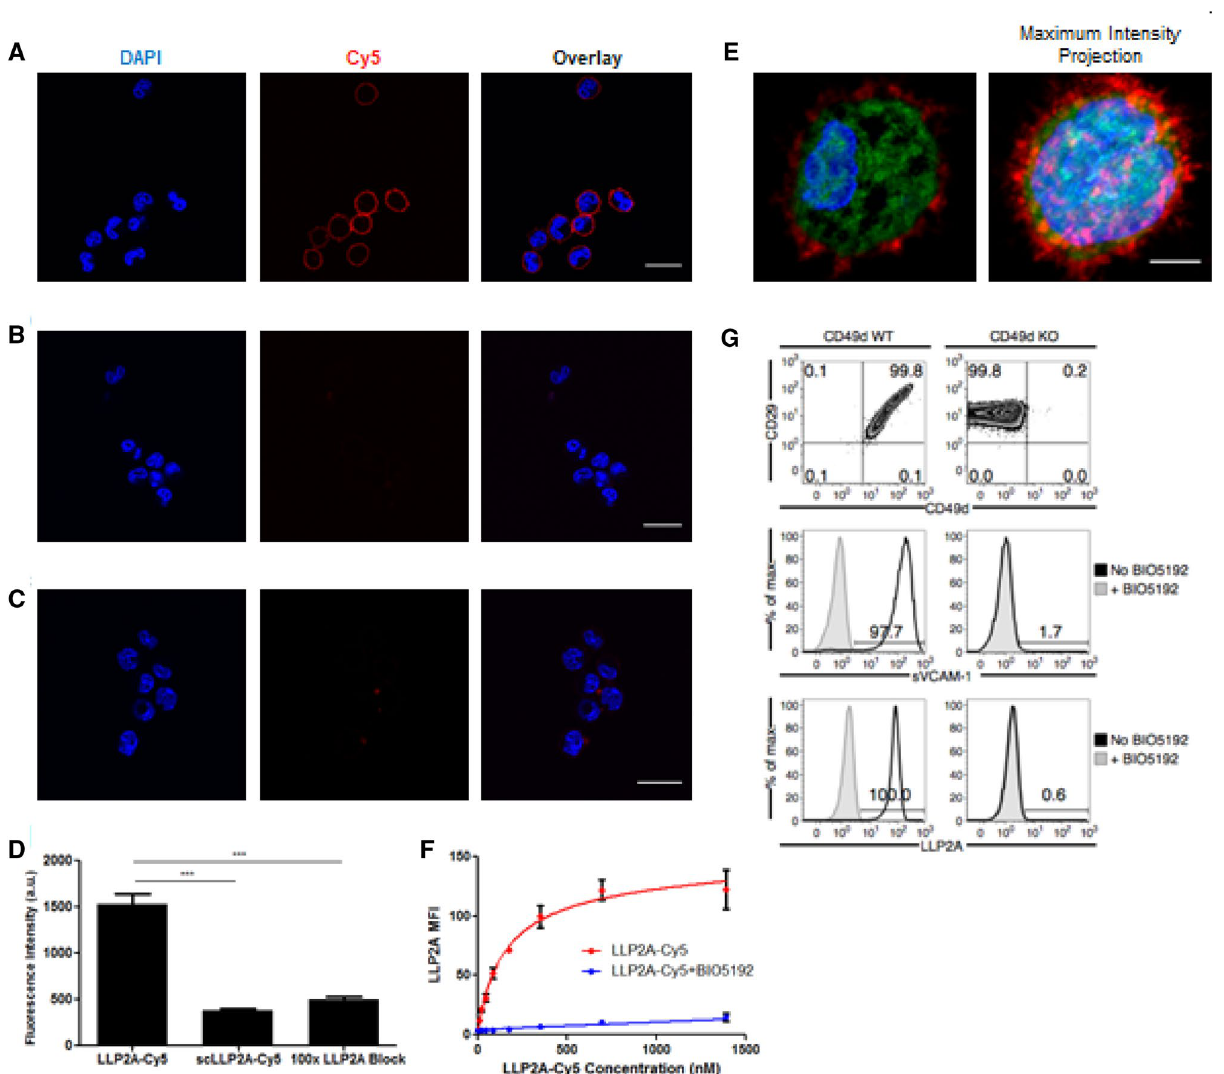
Figure 4. LLP2A-Cy5 specificity and affinity to VLA4 in vitro. ( A ) Strong cell surface fluorescence was observed in the WT 5TGM1-GFP cells incubated with LLP2A-Cy5 (1 µM, 15 min, at 4 °C). Blue, green and red colors represent nuclear stain, GFP, and Cy5 signal, respectively in all images (60x; scale bar: 20 µm). ( B ) Cell surface signal was decreased when the same was co-incubated with 100-fold excess of LLP2A-PEG4 blocking peptide (100 µM). ( C ) Cell surface binding was also reduced in the WT 5TGM1-GFP cells treated with scLLPA-Cy5 (1 µM, 15 min, at 4 °C). ( D ) Quantification of background corrected cell fluorescence showed significantly increased signal in LLP2A-Cy5 incubated cells, relative to scLLP2A-Cy5 and blocking (*** p < 0.001 1-way analysis of variance (ANOVA) with Bonferroni multiple comparisons test). ( E ) Representative high- resolution imaging of a single cell incubated with LLP2A-Cy5 for 2.5 h at 37 °C. Cells exhibiting minimal motion at 60 × magnification were imaged in a confocal 3D z-stack. Post-deconvolution visualization of a single confocal plane (left) and maximal intensity projection (right) of the confocal 3D z-stack (100x; scale bar: 3 µm) show strong cell surface binding with minimal internalization of LLP2A-Cy5. ( F ) FACS of LLP2A-Cy5 incubated with WT 5TGM1-GFP cells demonstrated selective binding of LLP2A-Cy5 to VLA4. WT 5TGM1- GFP cells and varying LLP2A-Cy5 concentrations (0-1400 nM) were co-incubated for 30 min and washed with Tyrode’s buffer containing 1% BSA. BIO5192 (100 nM) was used to evaluate non-specific binding. ( G ) LLP2A-Cy5 showed minimal binding to VLA4 KO cells relative to VLA4 + WT tumor cells. (Top) 1.5 × 10 5 WT and KO 5TGM1-GFP cells were assessed for α 4 and β 1 levels, and for binding with sVCAM-1 (Middle), and (Bottom) LLP2A-Cy5